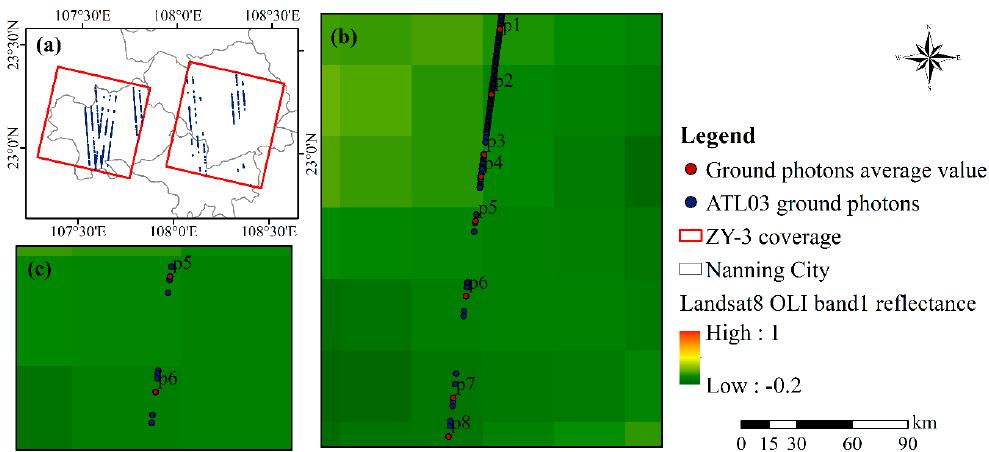
Figure 4. Methodology flowchart. The sequence of the five main steps is numbered and highlighted.